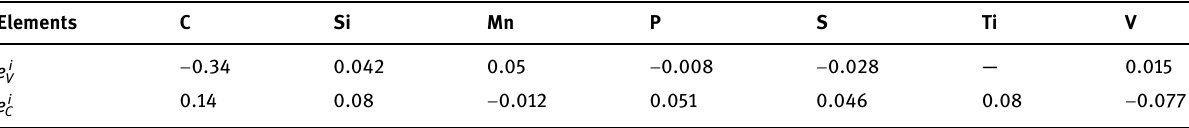
Table 3: Values of interaction parameters